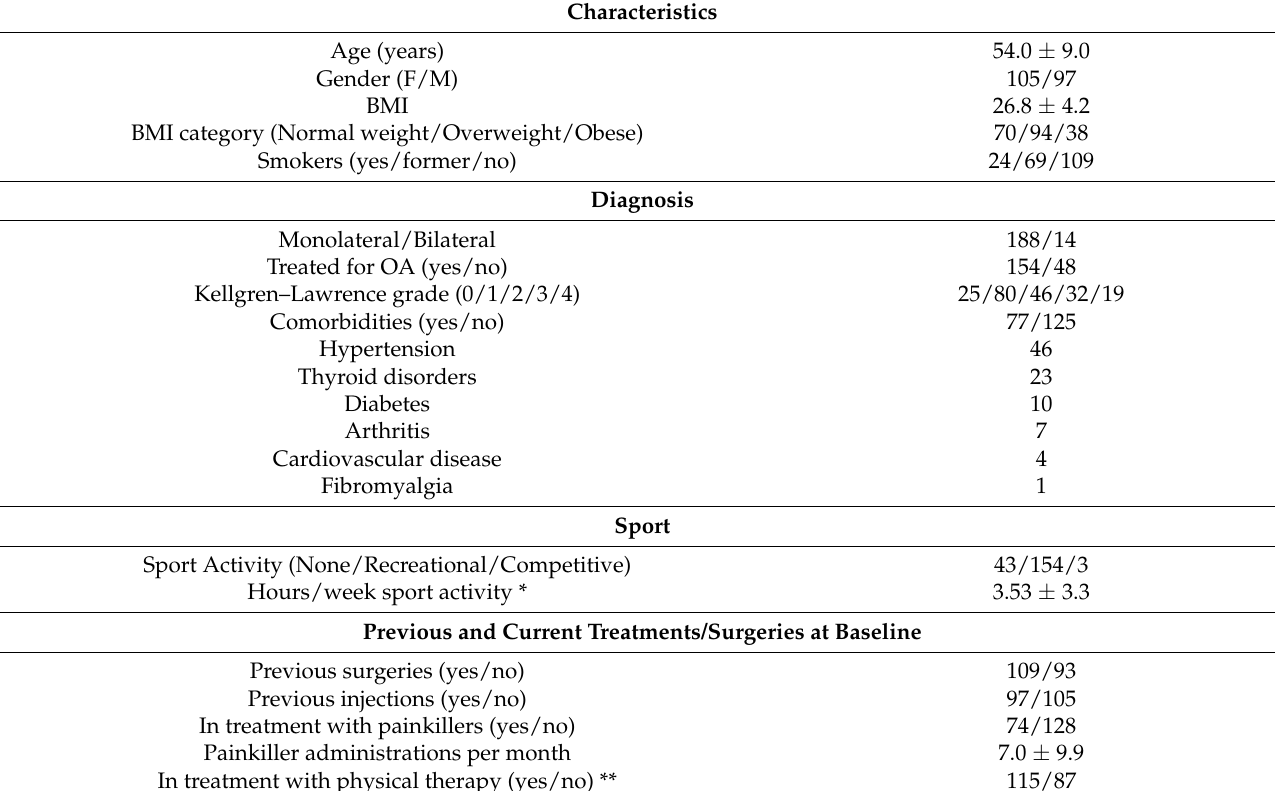
Table 1. Patient demographics.